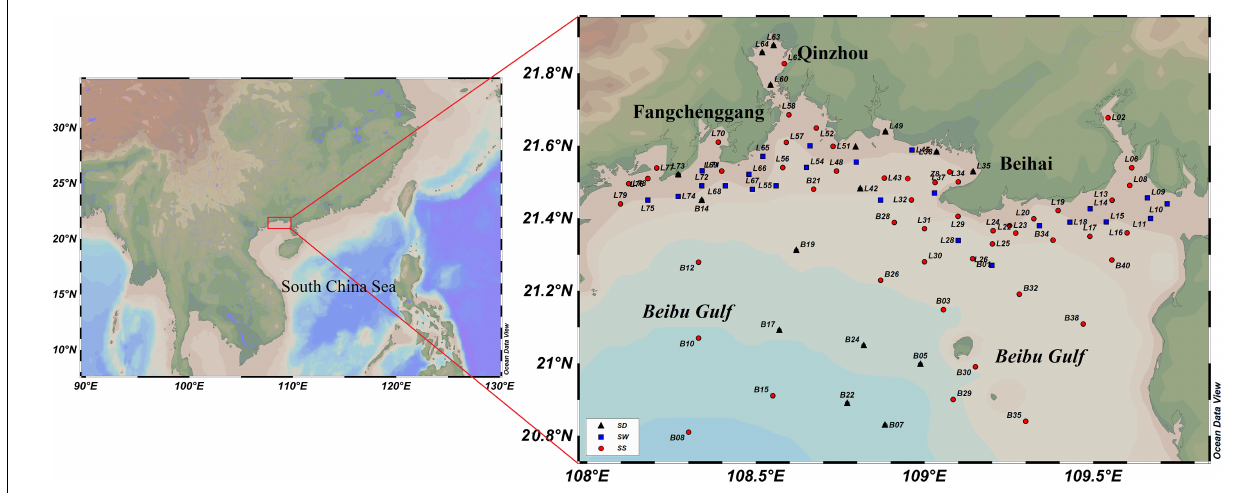
FIGURE 1 | Location of Beibu Gulf and sampling station distribution. L stations were sampled during L cruise, while B stations were sampled during B cruise. SD, sediment station, SW, seawater station, SS, sediment and seawater